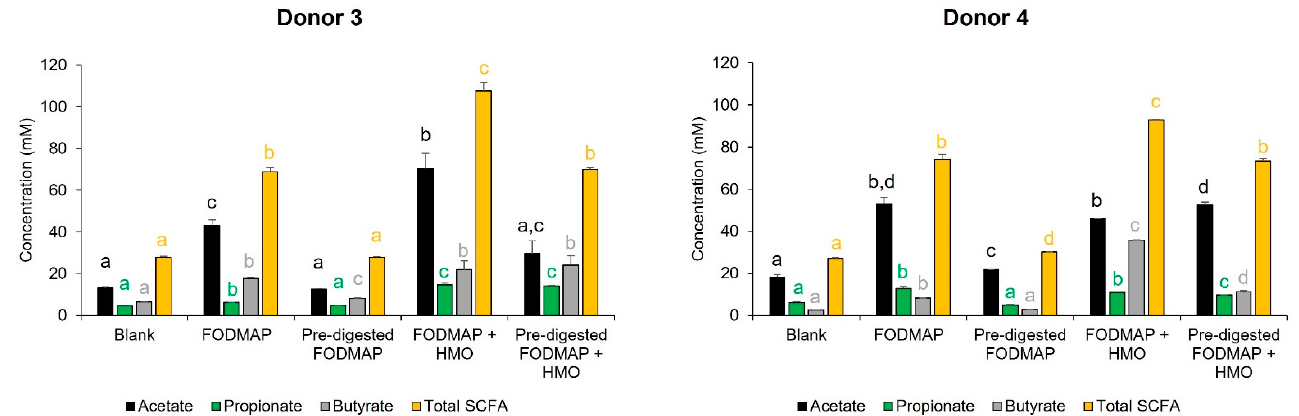
Figure 5. Changes in gas pressure using samples from the QuintSHIME ® model. Supernatants were collected from the QuintSHIME ® model on day 9 (treatment period) and evaluated in the short-term colonic batch model (48 h) to evaluate gas pressure ( n = 2 for each donor). Gas pressure evaluations during different time intervals of colonic incubation are shown. Different letters represent statisti- cally significant differences between the different test conditions ( p < 0.05). FODMAP = fermentable oligosaccharides, disaccharides, monosaccharides, and polyols; HMO = human milk oligosaccha- ride; SHIME = simulator of the human intestinal microbial ecosystem.